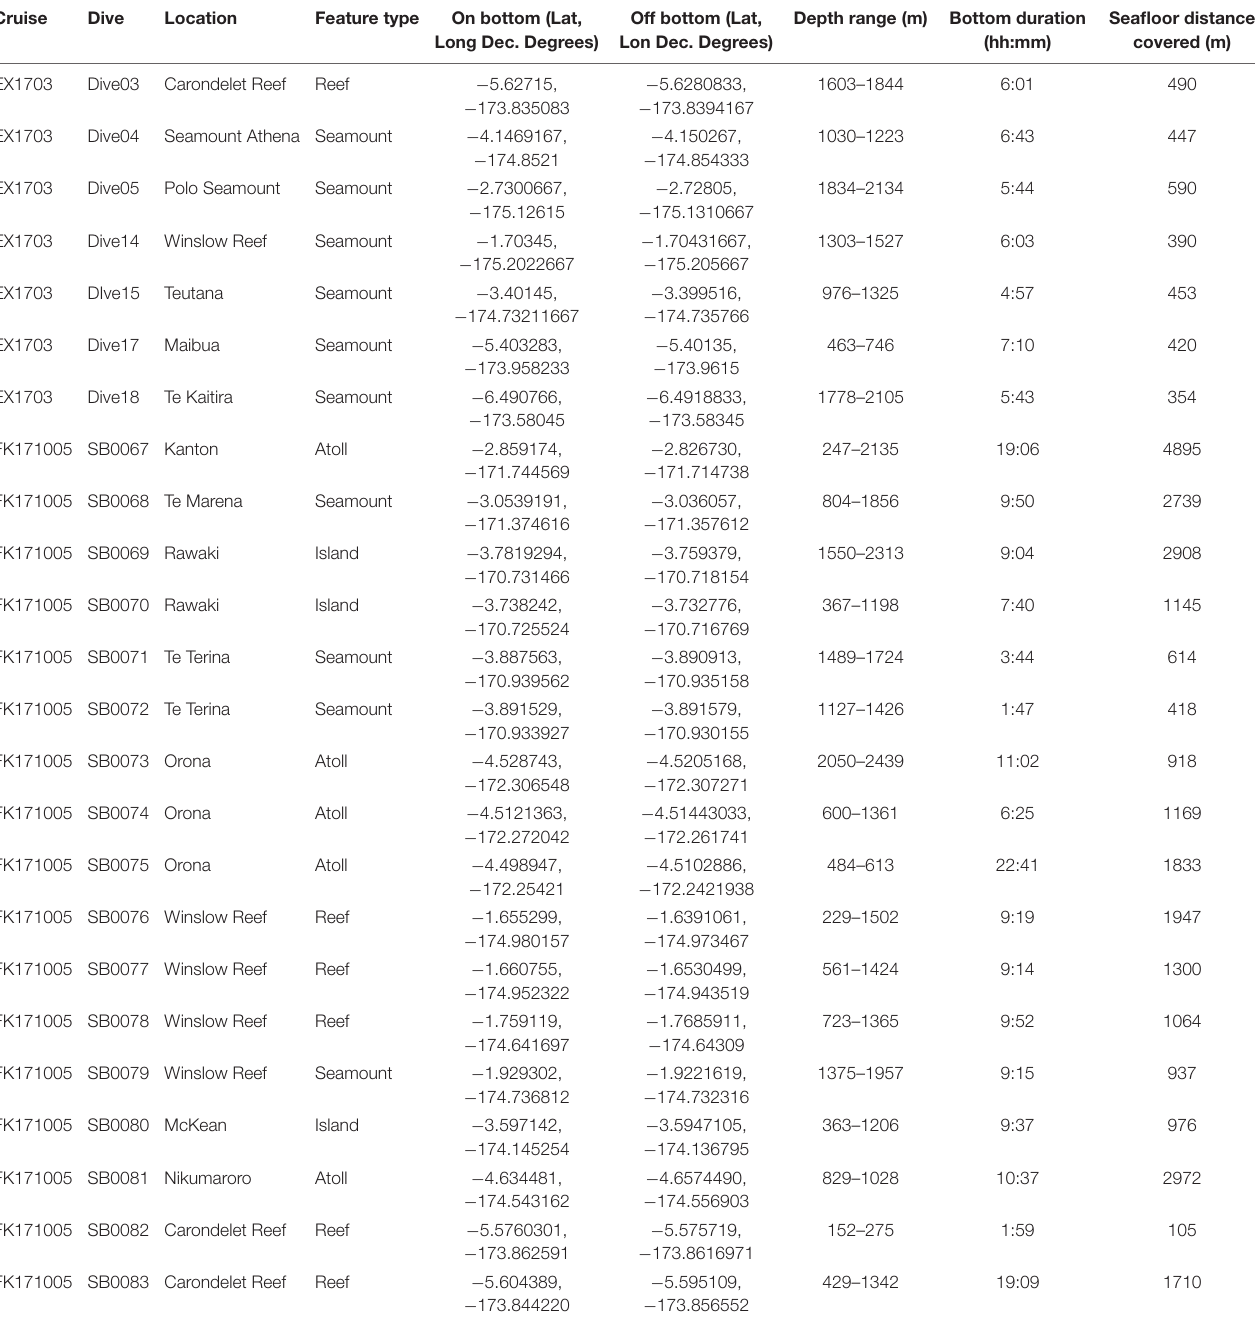
TABLE 1 | Summary of dives conducted at seamounts, islands, atolls, and reefs during EX1703 and FK171005. Cruise